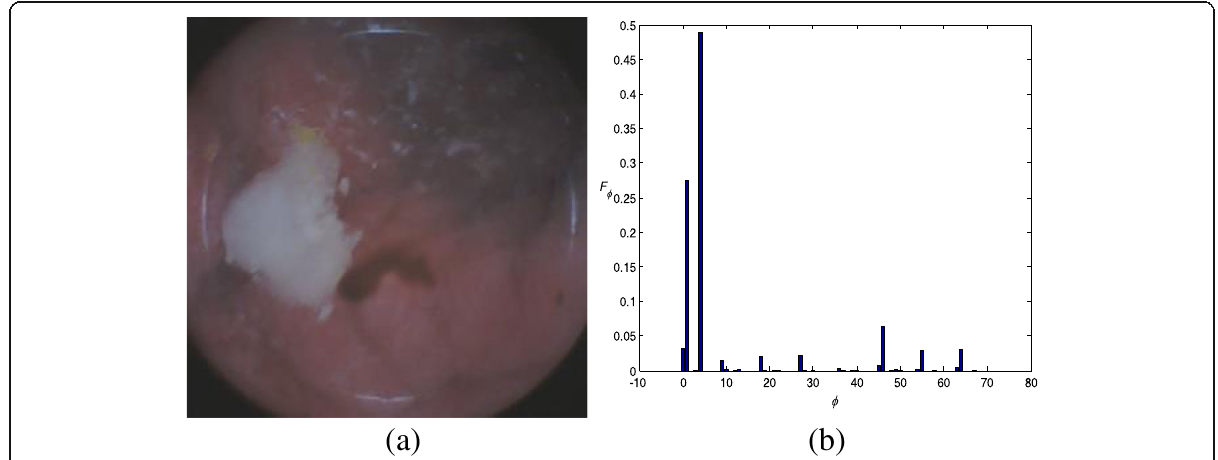
Fig. 2 The color histogram of the case image Q : a case image Q and b quantized color histogram of the case image